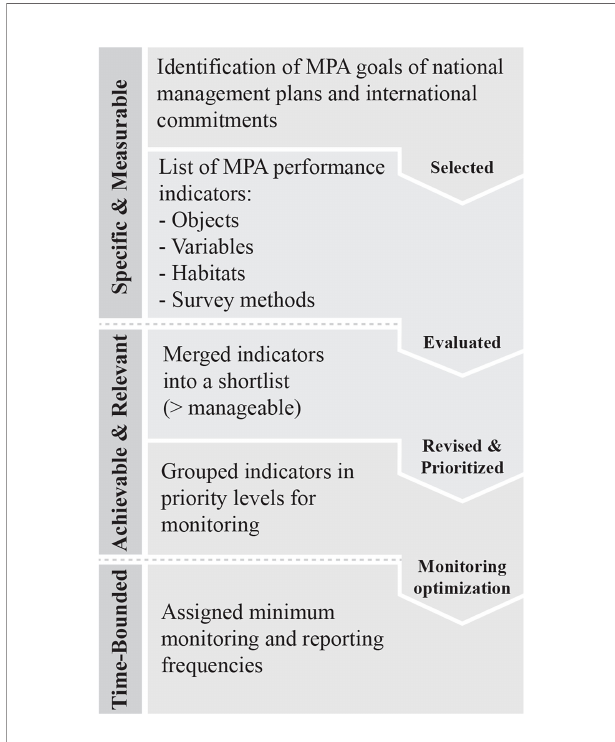
FIGURE 1 | Work fl ow for developing a list of SMART MPA performance